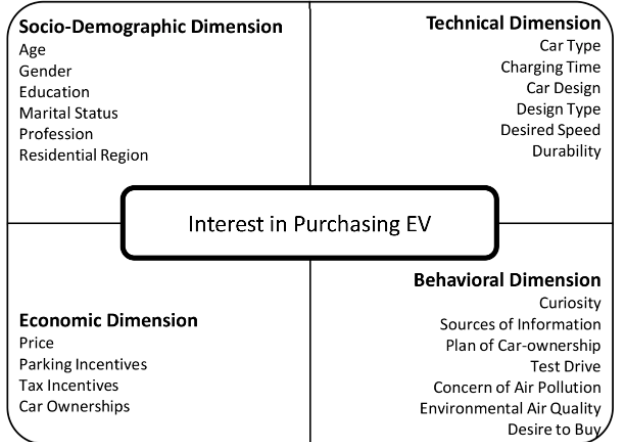
Figure 3. Areas of consumer interest in purchasing EVs according to Alamsjah et al. (2021)